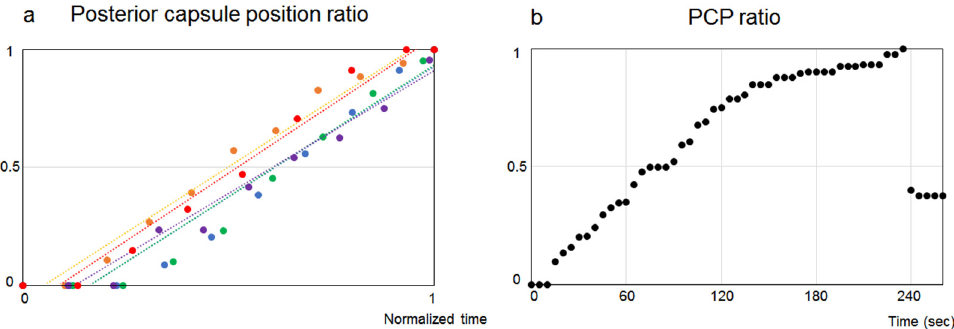
Figure 6. The PCP ratio correlated well with the laser irradiation time and laser energy amount. ( a ): The PCP ratio of 5 eyes (total laser energy amount 16.6–25 J, laser irradiation time 37.5–48.7 s). The coefficient of determination (R2) for each regression line was 0.938–0.981. The PCP ratio within this irradiation time correlated well with the laser irradiation time and laser energy amount. ( b ): The PCP ratio in lens P, which was irradiated for 261 s, linearly increased up to about 70 s (R2 = 0.981), with the slope then decreasing, followed by a burst at 240 s.